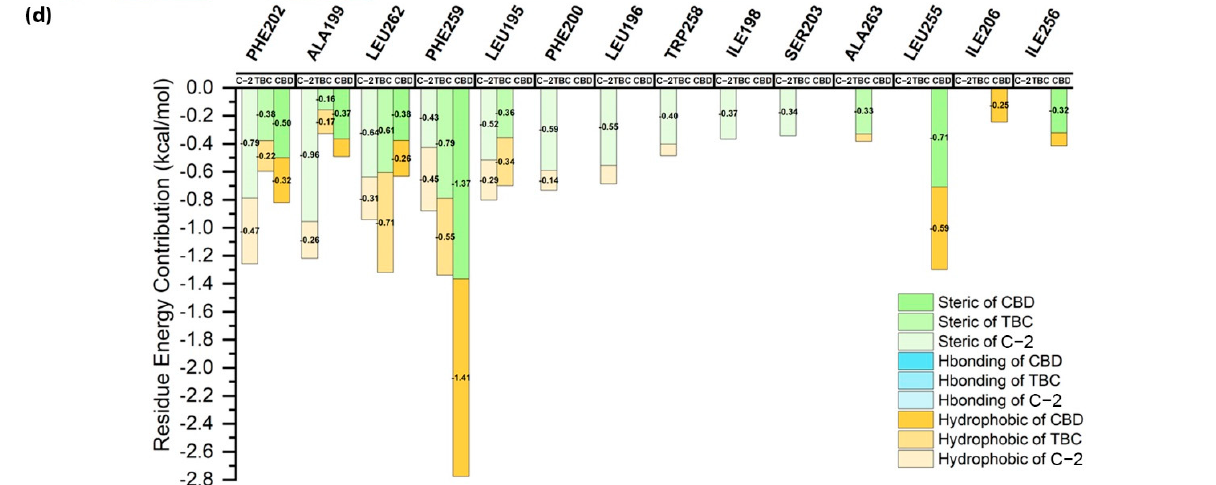
Figure 5. The detailed interactions and residue energy contribution of C-2, TBC and CBD in site I. ( a ) The detailed binding pose of C-2 in site I. ( b ) The detailed binding pose of TBC in site I. ( c ) The detailed binding pose of CBD in site I. ( d ) The comparisons of residue energy contribution of binding residues for these AMs in site I.